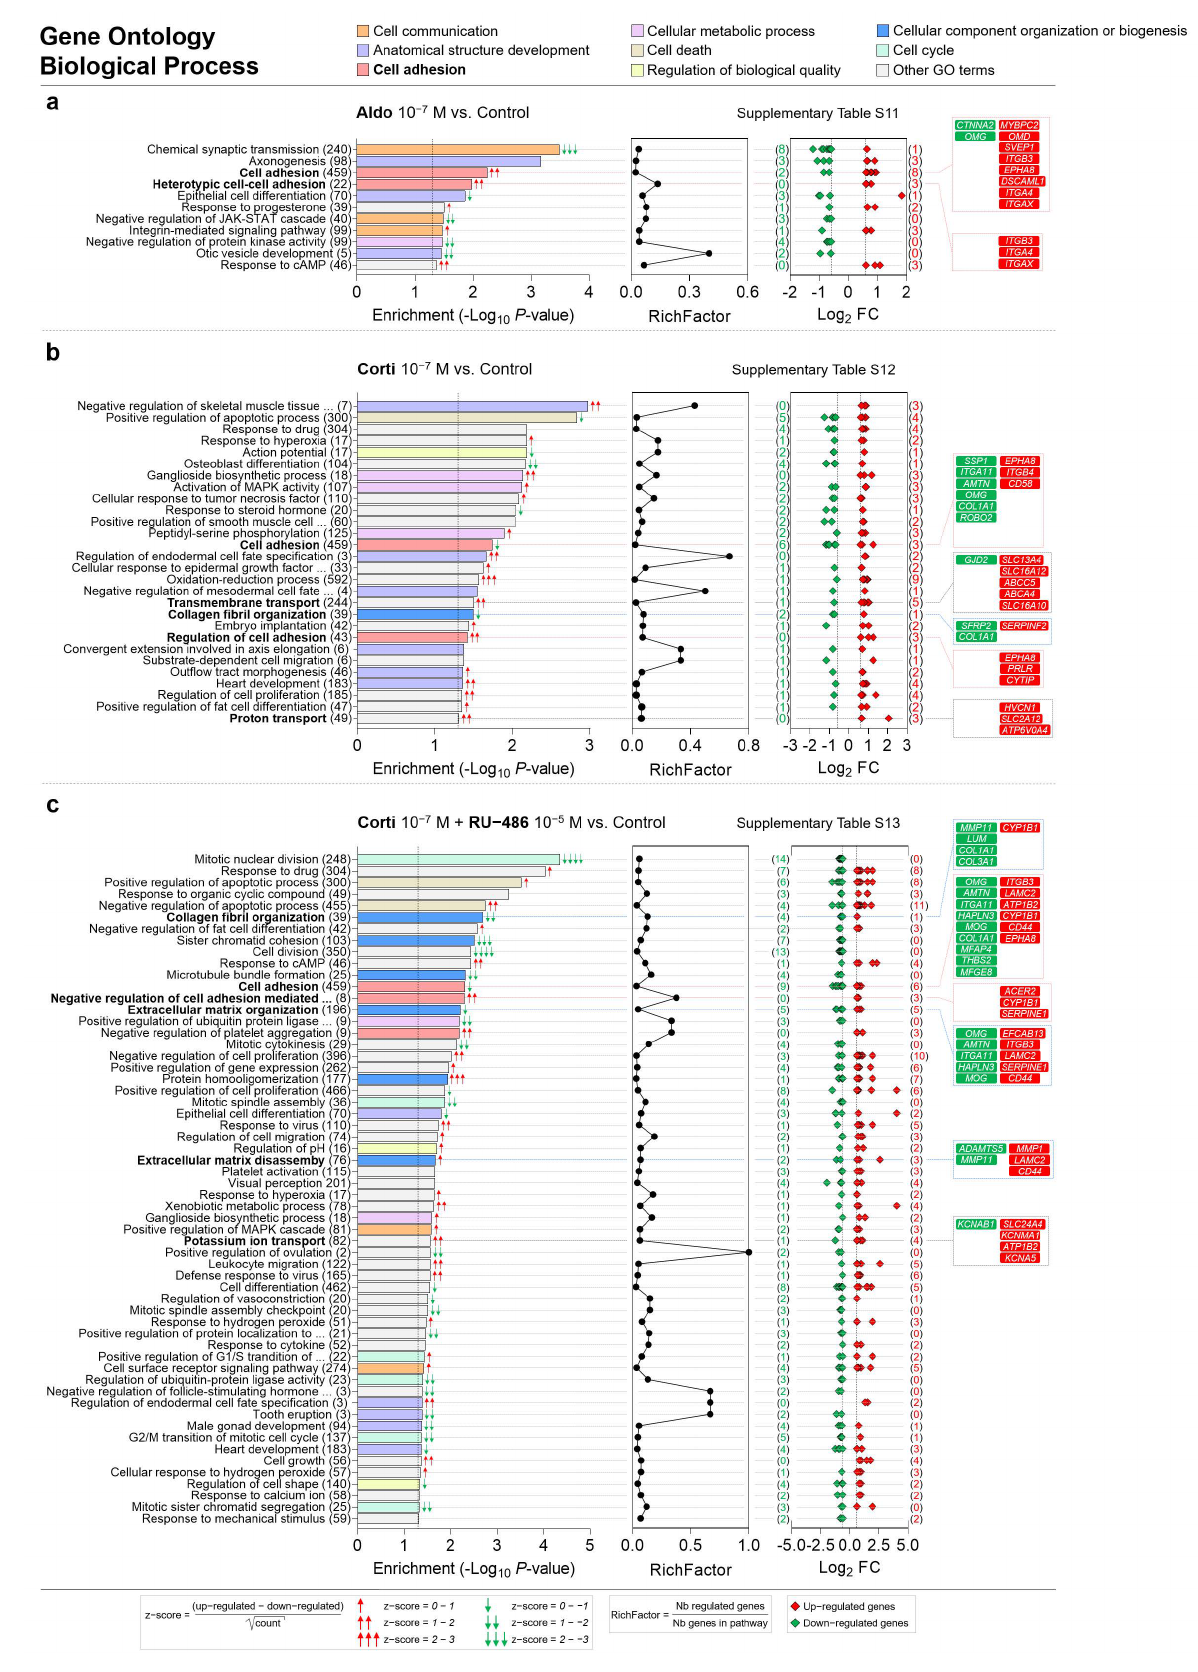
Figure 9. Cell communication, anatomical structure development, cell adhesion, cellular metabolic process, cell